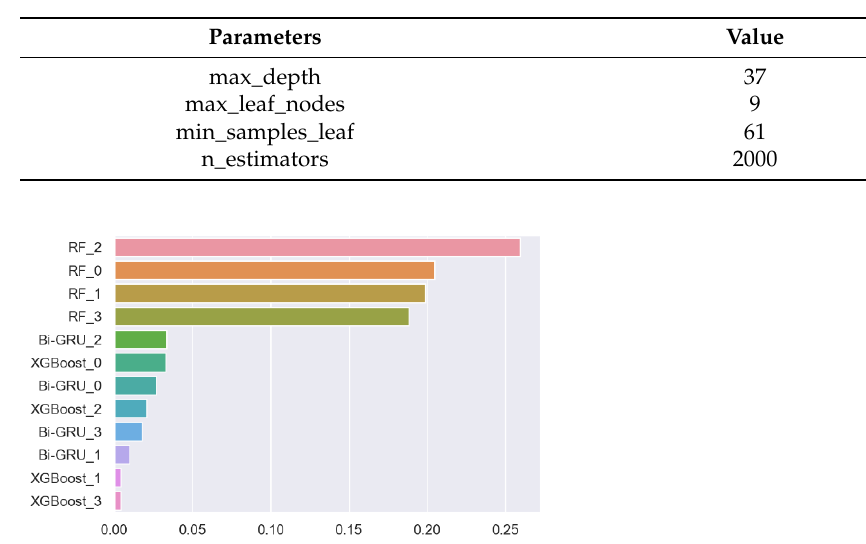
Figure 34. MFELCM2 feature importance.